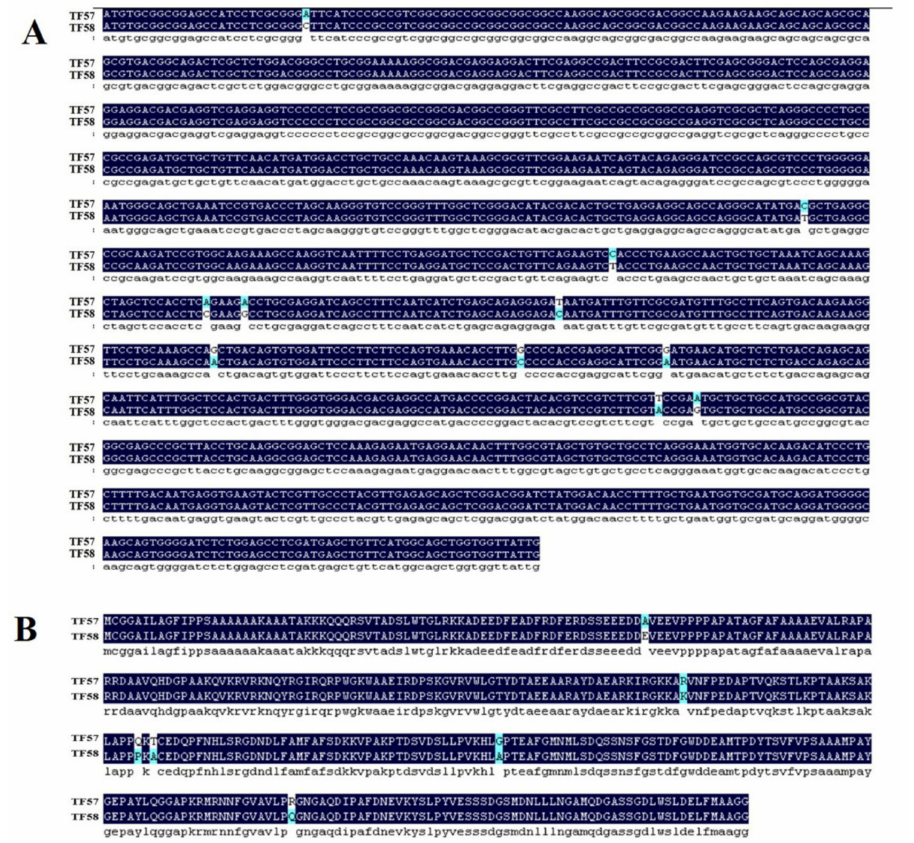
Figure 2. CDS and amino acid sequence comparison of HvERF2.11 gene between TF57 and TF58. ( A ) CDS sequence comparison of HvERF2.11 gene between TF57 and TF58. ( B ) Amino acid sequence comparison of HvERF2.11 gene between TF57 and